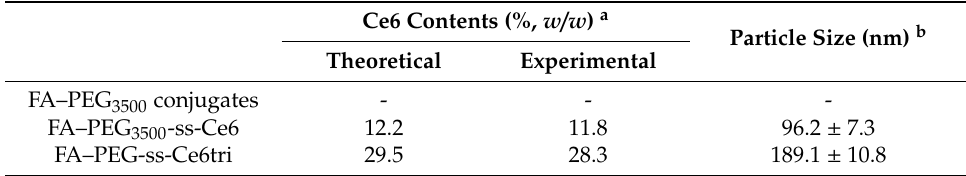
Table 1. Characterization of FA–PEG 3500 and Ce6-conjugated